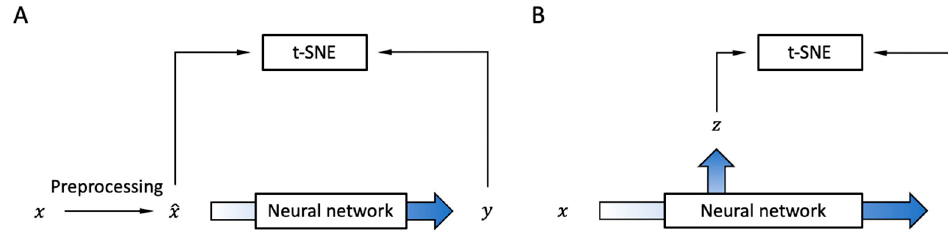
Figure 2. Comparison of the original parametric t-SNE and the suggested method of this work. Both methods produce a low-dimensional representation y of the high-dimensional data x using a neural network. ( A ) The original parametric t-SNE. The input is usually a preprocessed version ˆ x of the EEG. The optimal way to preprocess the EEG is not known. ( B ) The suggested method. The input x is the raw EEG data, and a new high-dimensional representation z of the data is extracted from the latent space of the network. An advantage of this approach is that the preprocessing step necessary in ( A ) is eliminated.